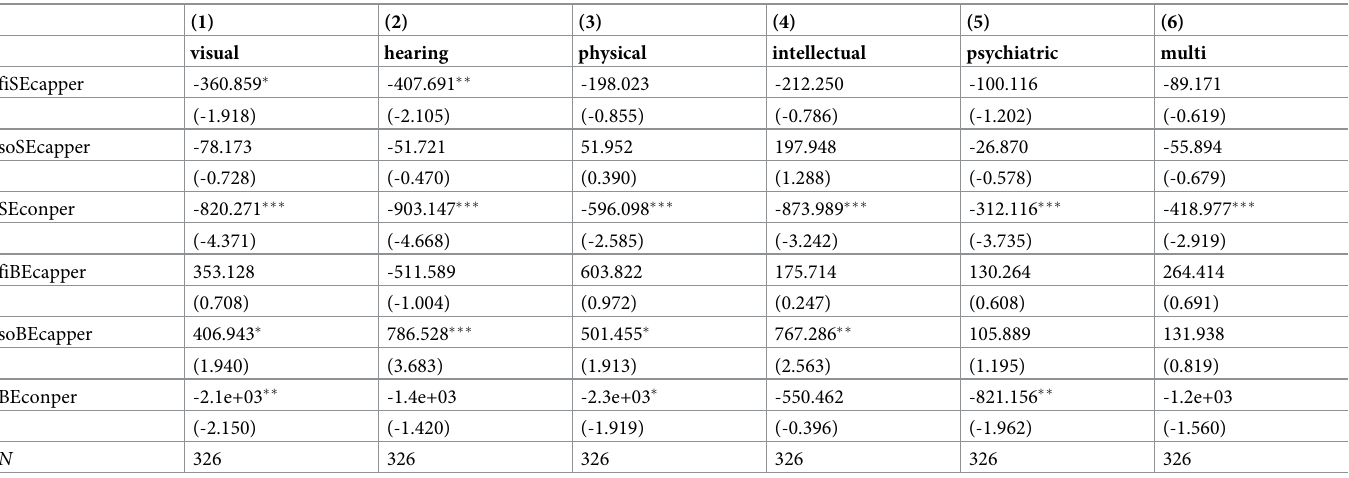
Table 7. The results of capital expenditures on subtypes of RSE